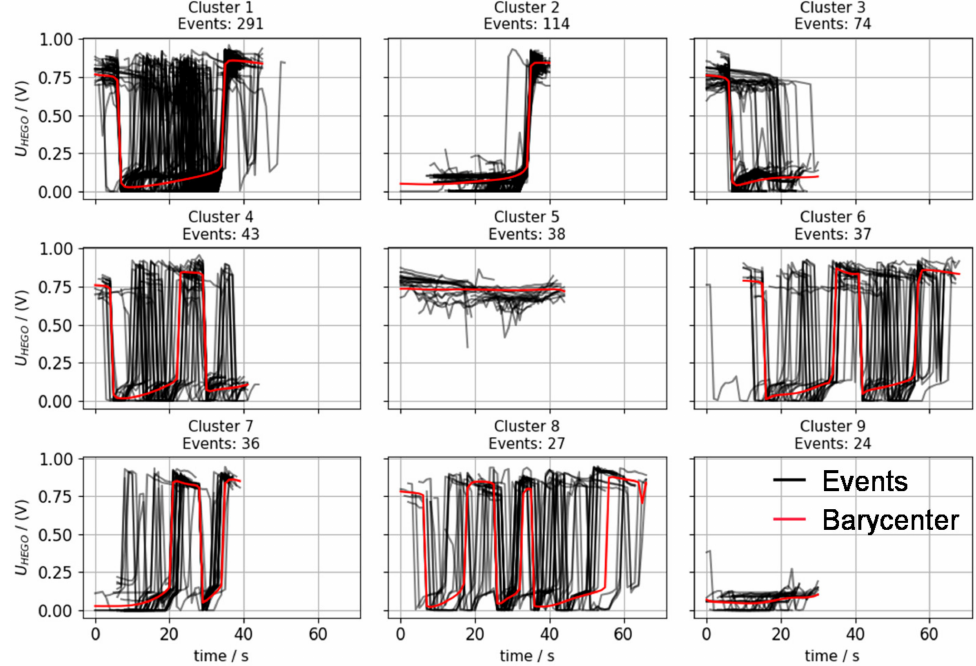
Figure 7. Extract of cluster identified for the downstream lambda sensor voltage for 842 NO X